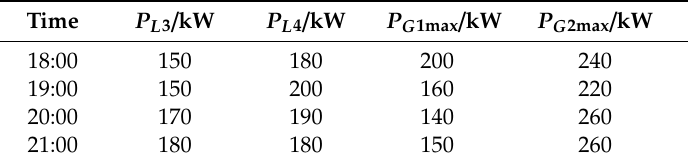
Table 2. The predicted value of virtual power and virtual load for 18:00–21:00.